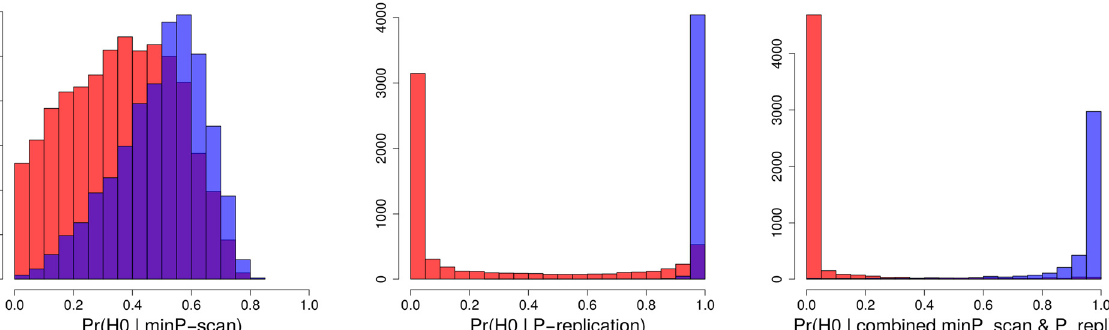
Fig 2. Distribution of estimated posterior probabilities that a P-value is a false finding. Color refers to whether the actual signal is genuine (red) or false (blue). Purple color denotes the overlap of genuine and false signals. First graph : Estimated probability that the smallest P-value in a scan (minP) is a false finding. Second graph : Estimated probability that the signal from the scan with the smallest P-value is a false finding when evaluated in a replication study. Third graph : Estimated probability that the finding is false based on the combined P-value (the smallest scan P-value combined with the replication P-value).